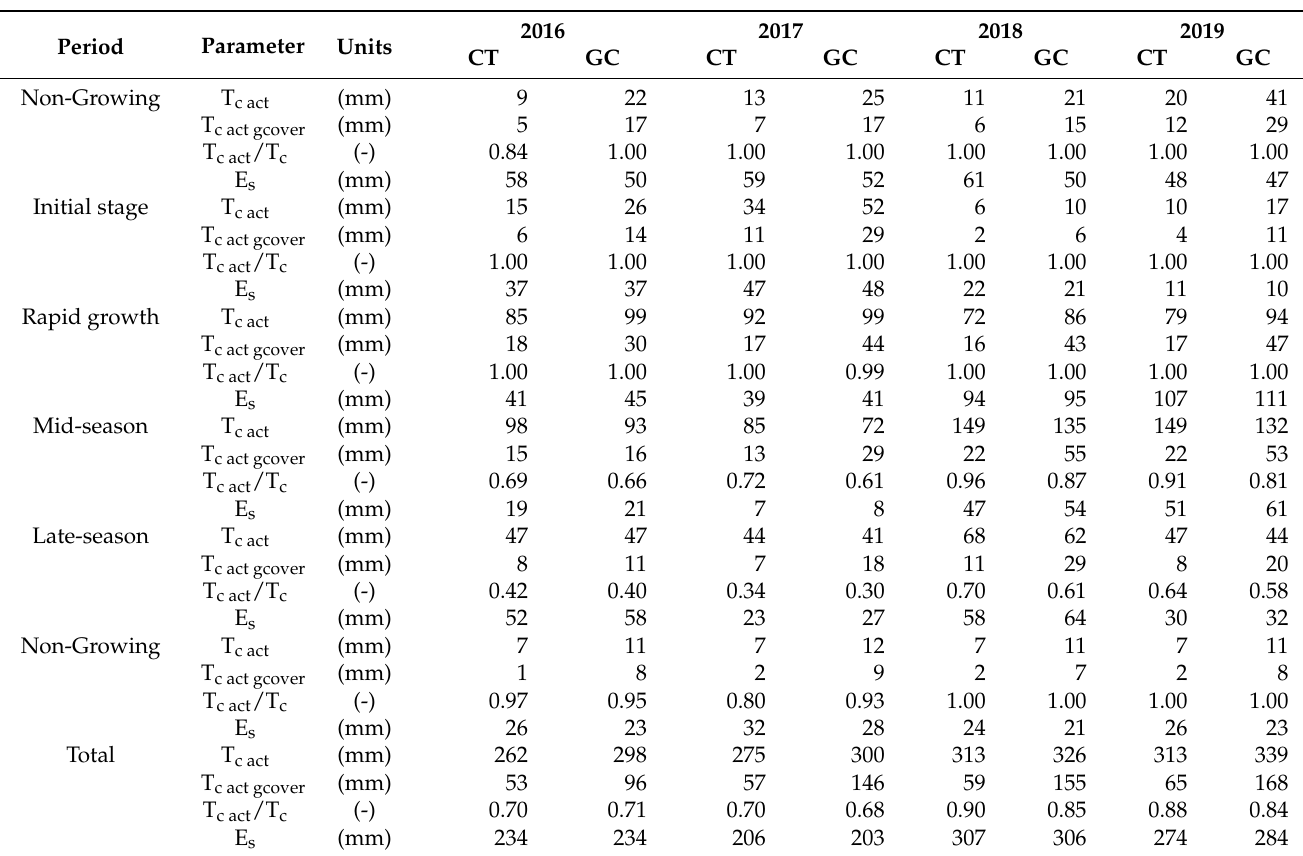
Table 9. Evapotranspiration partitioning in the Monferrato vineyard plots during the different crop